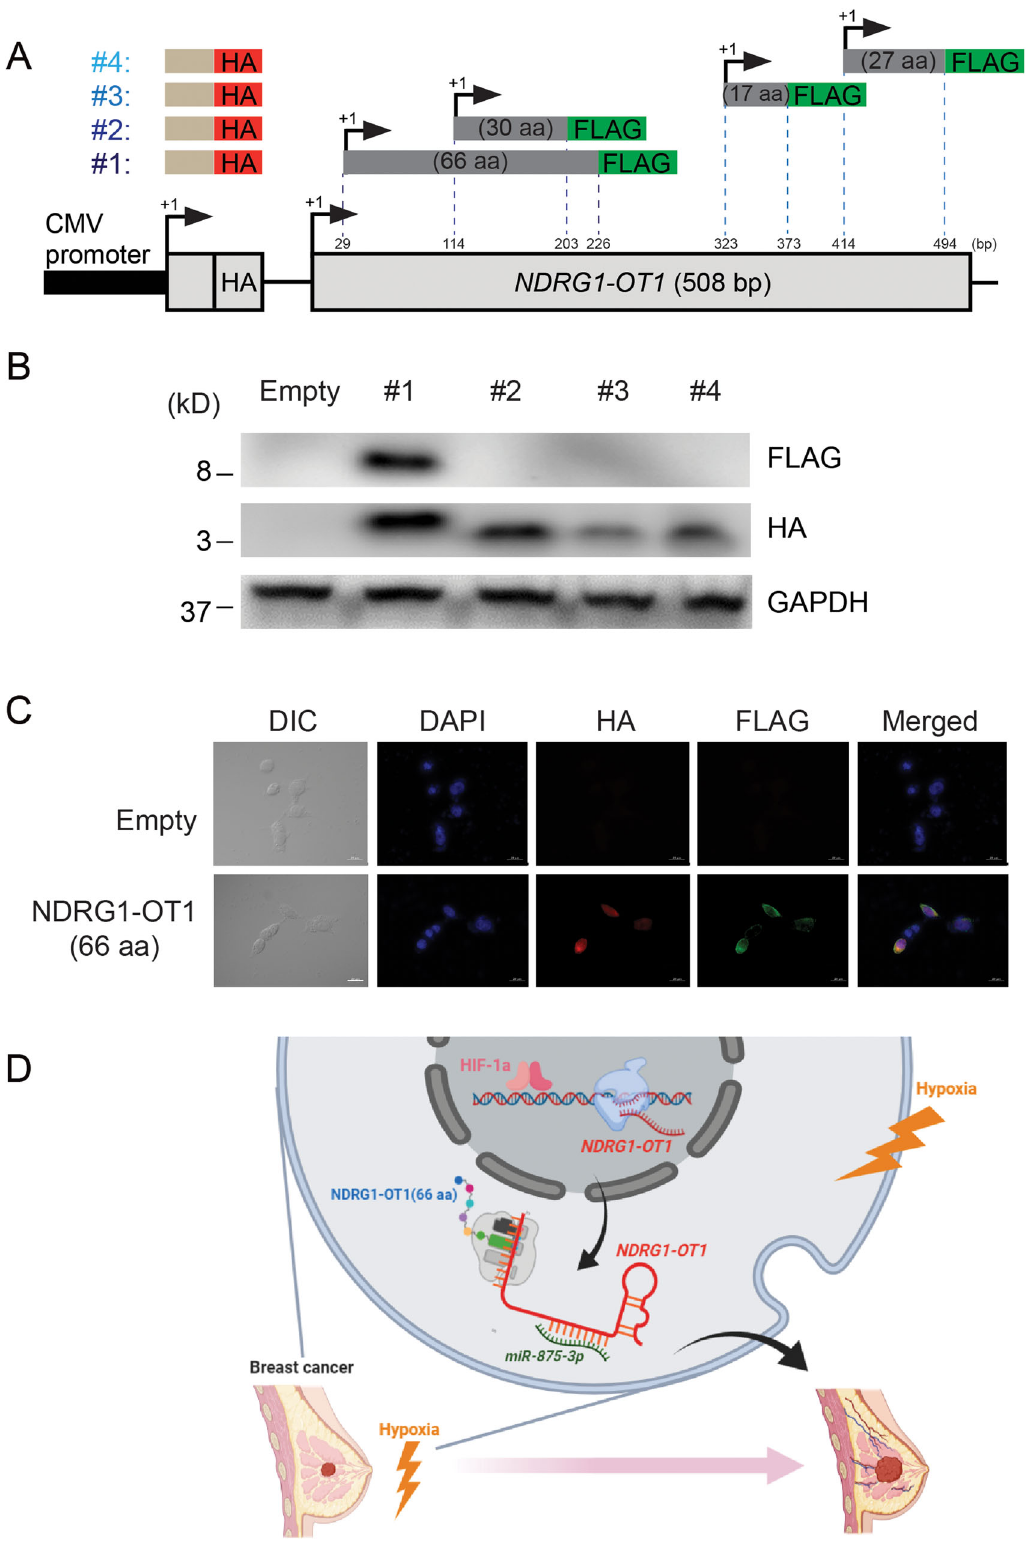
Fig. 7 NDRG1-OT1 encodes a small peptide of 66 amino acids. A Schematic representation of FLAG-tagged constructs of four predicted translatable regions. The HA tag was incorporated into the CMV promoter of each plasmid. B Western blots of HEK293T cells transfected with FLAG-tagged NDRG1-OT1 plasmids from panel A . FLAG: NDRG1-OT1; HA: translation positive control; GAPDH: loading control. C Immuno fl uorescence staining of NDRG1-OT1 (66 a.a.). DIC: differential interference contrast microscopy; DAPI: nucleus marker. Scale bar: 20 μ m. D A proposed model for illustrating the regulatory mechanisms and function of hypoxia-induced lncRNA NDRG1-OT1 in breast cancer cells.